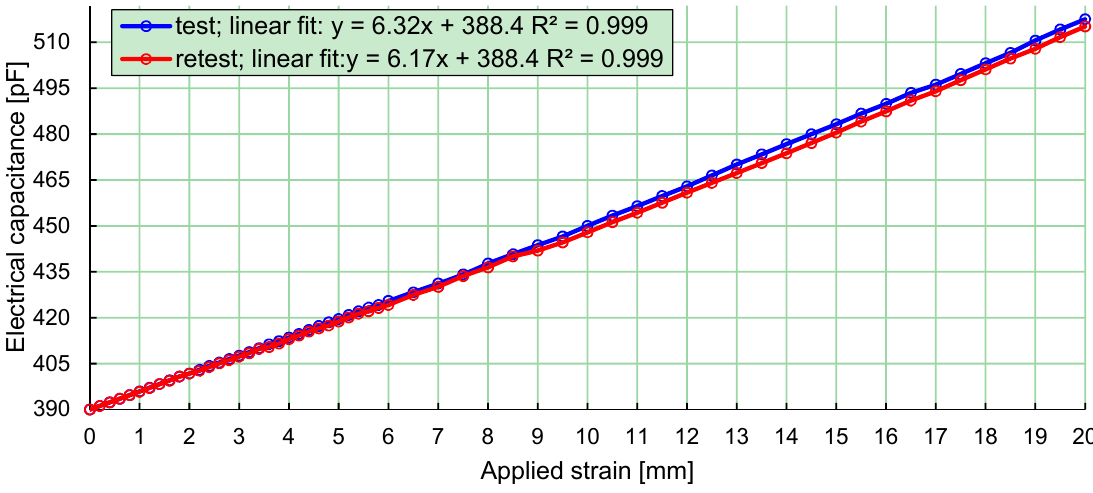
Figure 5. Change in the slope of a linear fitting of the relation between strain of a PBS and the electrical capacitance measured using the developed system. The graph shows the percentage change in the slope and the slope in